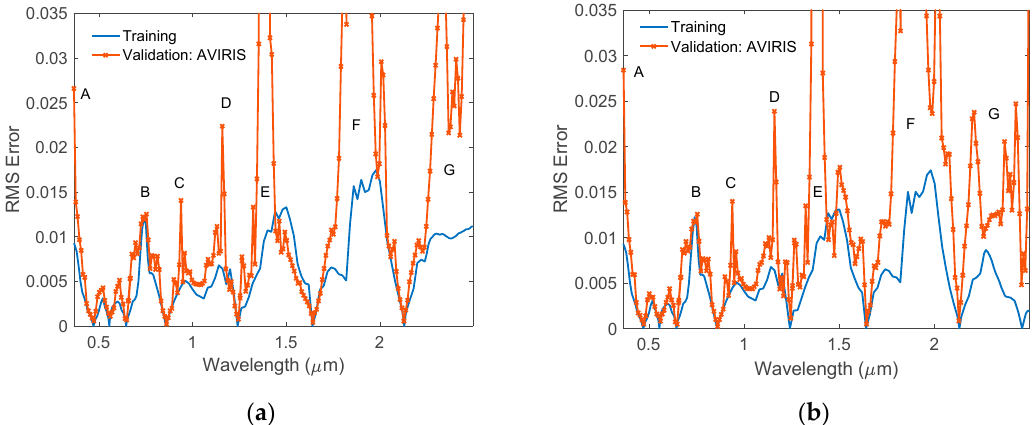
Figure 11. ( a ) Validation RMS errors of the simulated reflectances using HSBR model. The measured AVIRIS data were assumed to be the “true values”; ( b ) Validation RMS errors of the simulated reflectances using HSBR model with 8 hinge wavelengths. The additional hinge point is at 2.46 μ m. The measured AVIRIS data were assumed to be the “true values”.